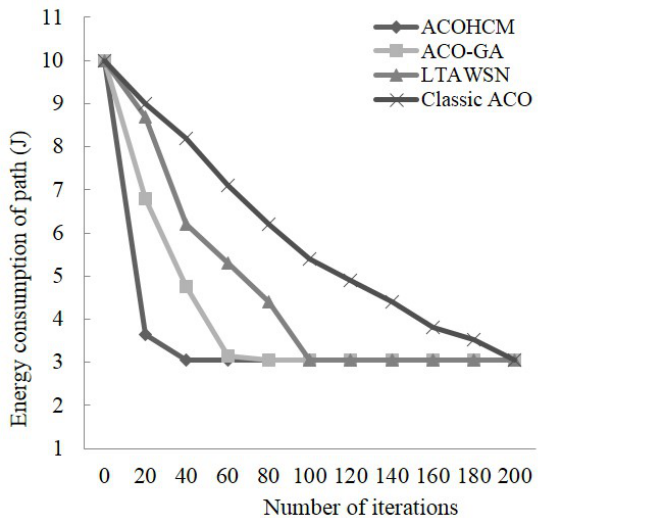
Figure 2. Convergent features of the different